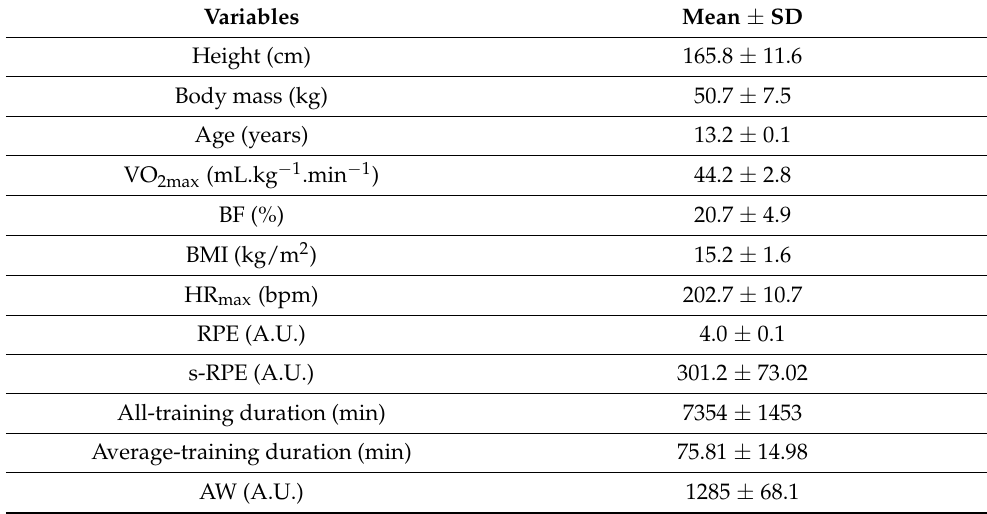
Table 1. Descriptive characteristics of the